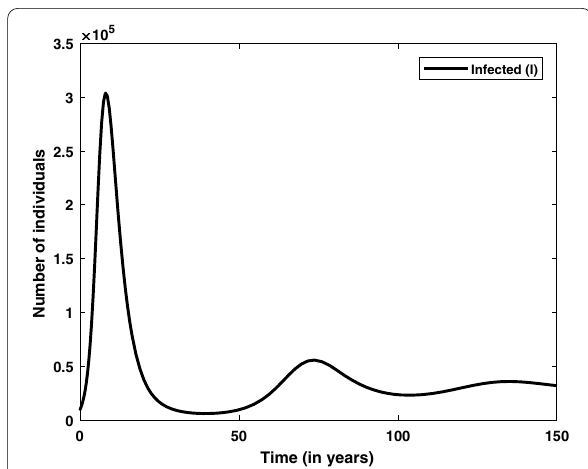
Fig. 5 Numerical solution of SIR model with viral dynamics. Model is simulated for the initial values S = 10 6 , I = 10 4 , R = 0 and parameter values b = 1 / 60, d = 1 / 60, β = 10 − 6 , γ = 1 / 3